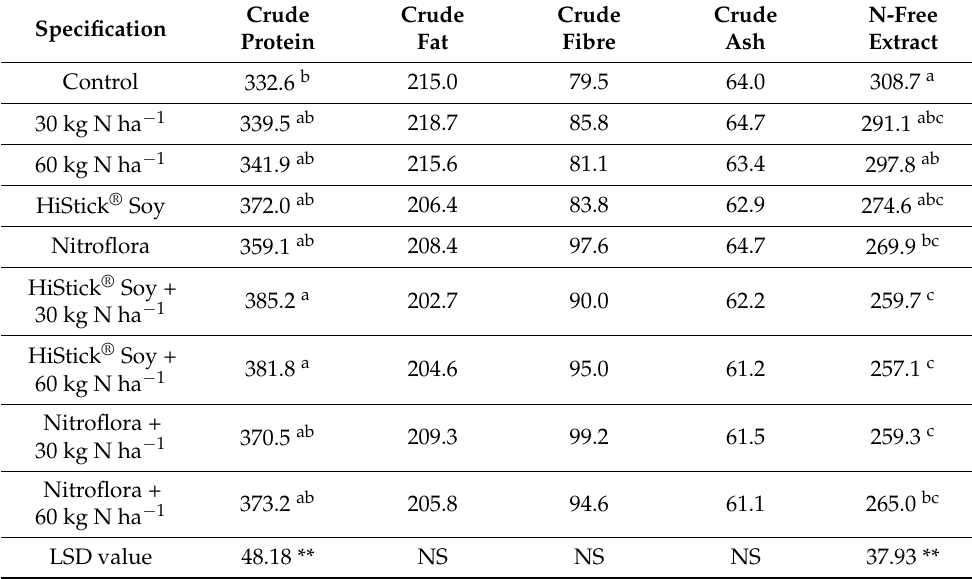
Table 5. The effect of N supply and inoculation on organic components and ash contents in soybean seeds (g kg − 1 DM). Crude Crude Specification Protein